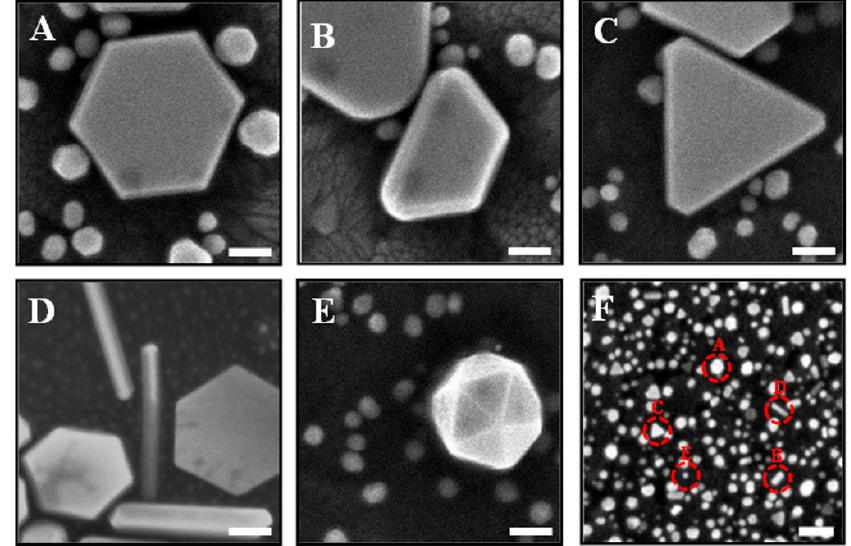
Figure 1. Field Emission Surface Scanning Electron Microscopy (FESEM) images of Au nanoplates grown on the substrate using the seed-mediated growth method. Variable structures of Au nanoplates were obtained, such as ( A ) symmetric hexagonal, ( B ) truncated pentagon, ( C ) triangular, ( D ) flat rod, ( E ) irregular shape; ( F ) the growth of Au in small sizes on the surface substrate. Scale bars are 100 nm.